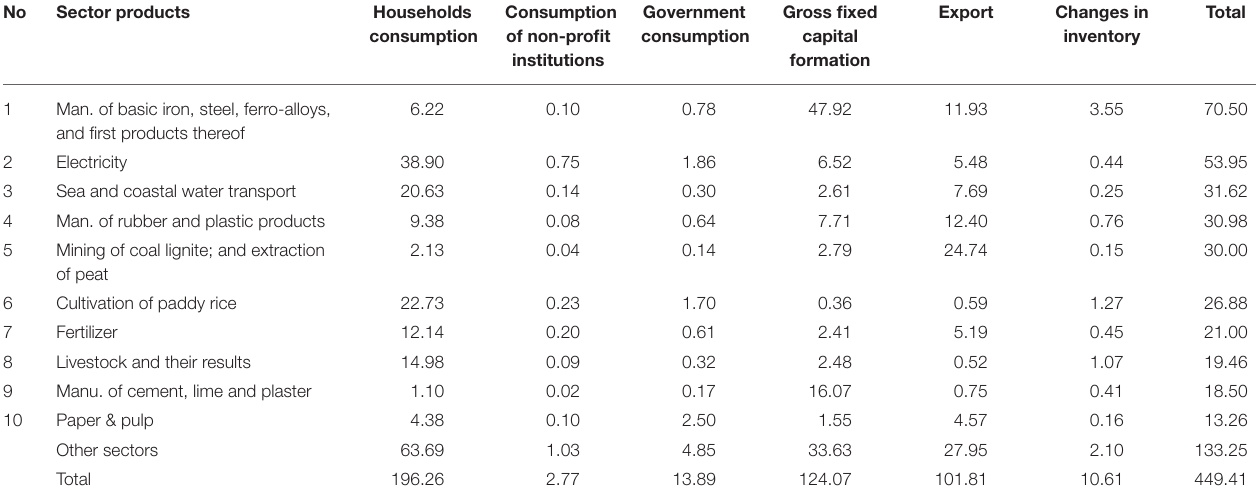
TABLE 3 | Top 10 total environmental costs from emissions by sector in Indonesia in 2010 (Trillion